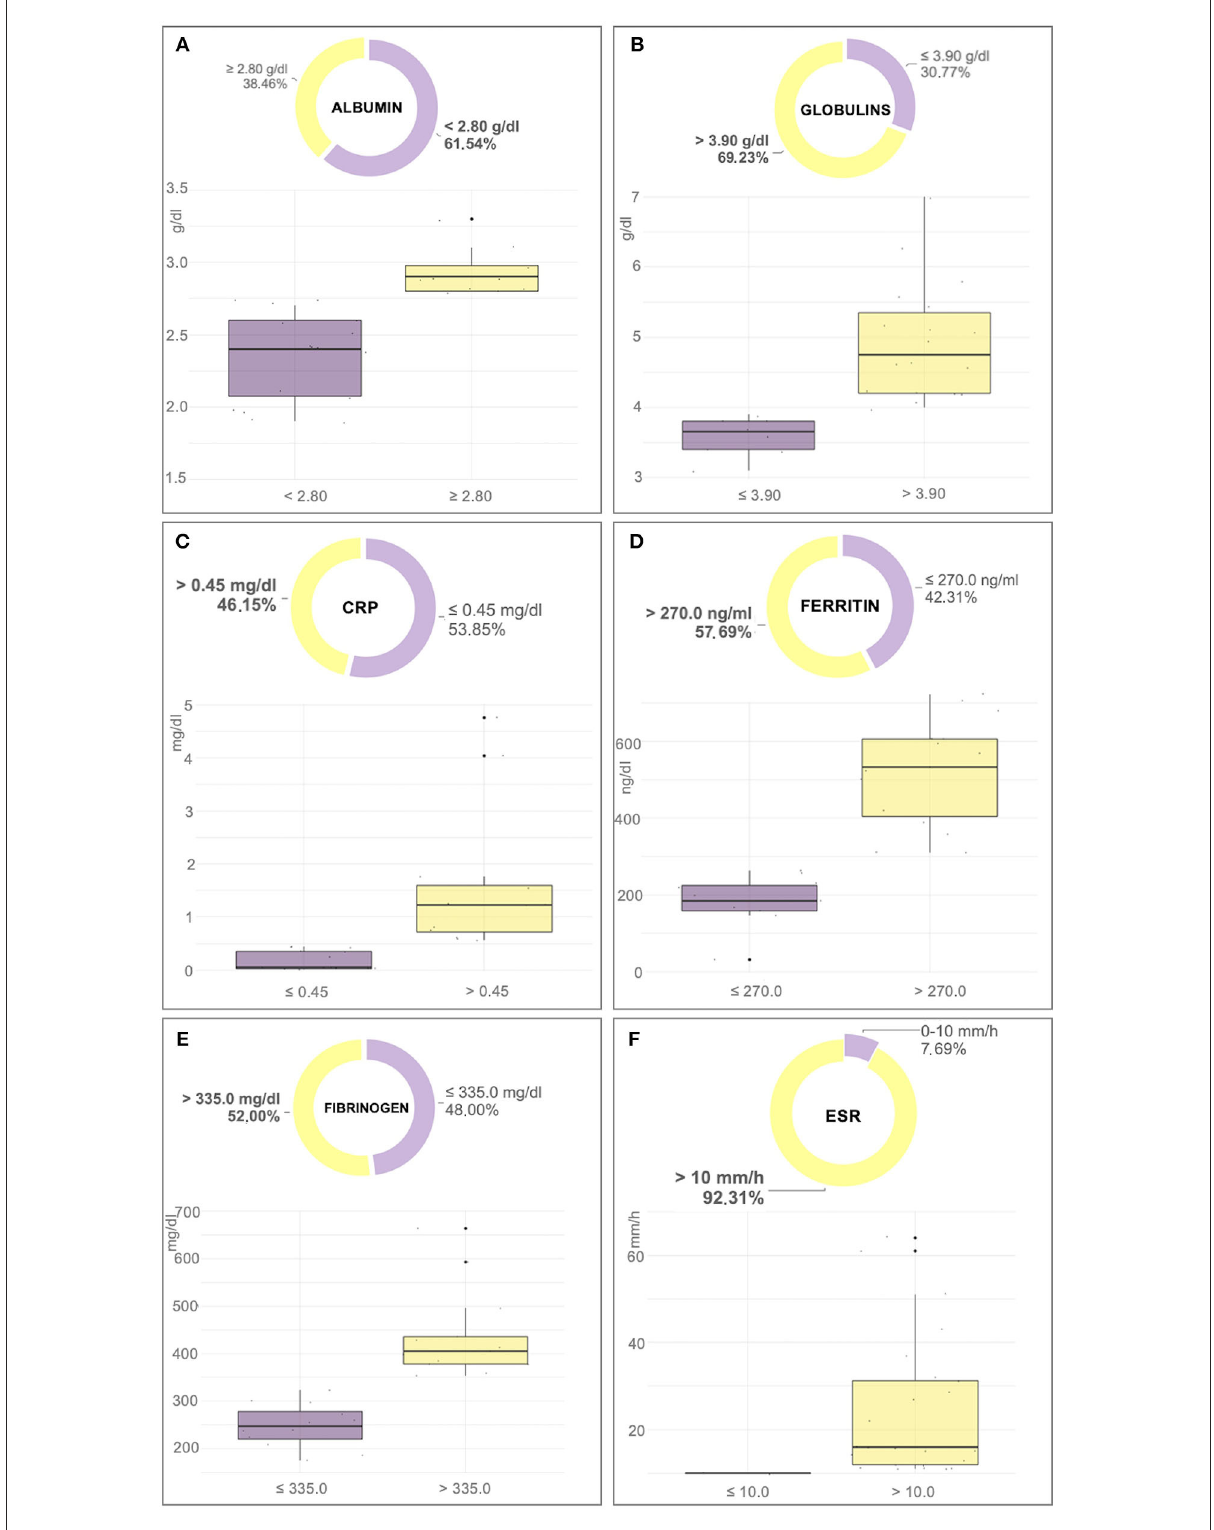
FIGURE1 Box-plot and pie chart graphs of albumin (A) , globulins (B) , C-reactive protein (CRP) (C) , ferritin (D) , fibrinogen (E) , and erythrocyte sedimentation rate (ESR) (F) in dogs affected by an active form of canine leishmaniosis.